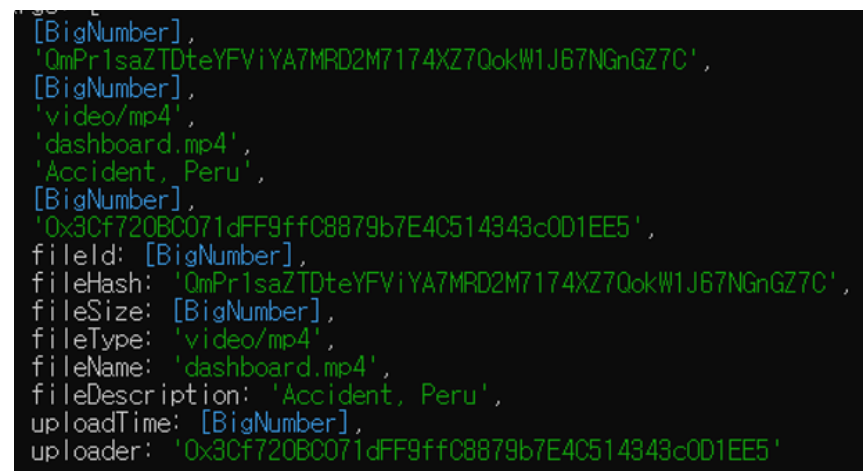
Figure 19. Smart contract events.